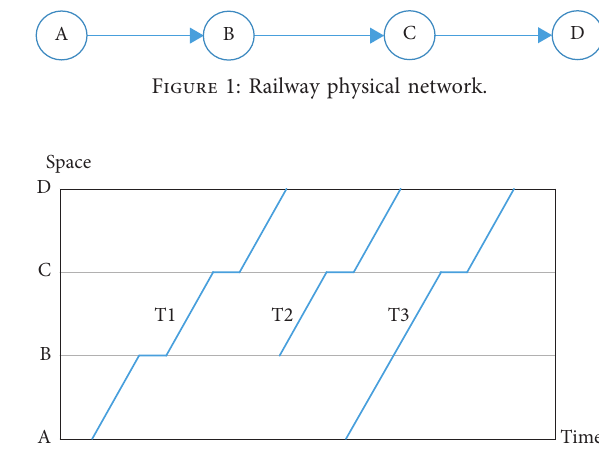
Figure 2: Train running